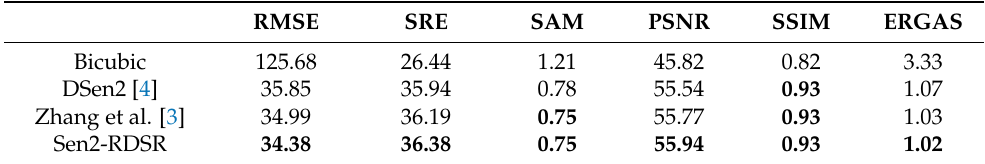
Table 2. Results of the sharpening of 20 m bands.